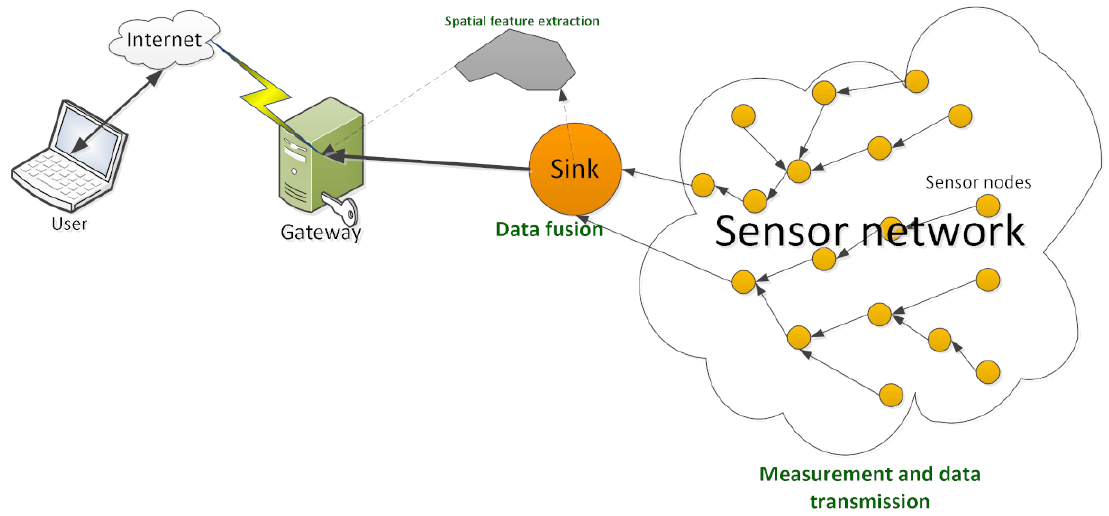
Figure 1. View of a centralized spatial computing approach in sensor